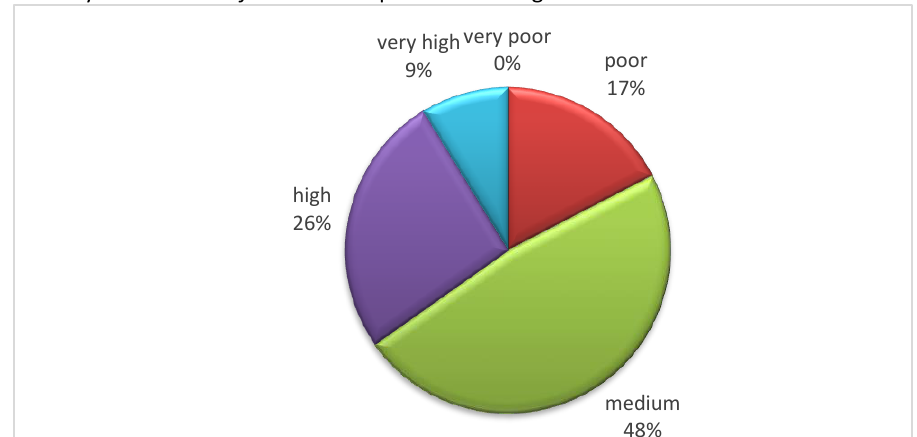
Figure 2. Ibnu Thufail Students’ HOTS based on Problem-Solving Indicator in